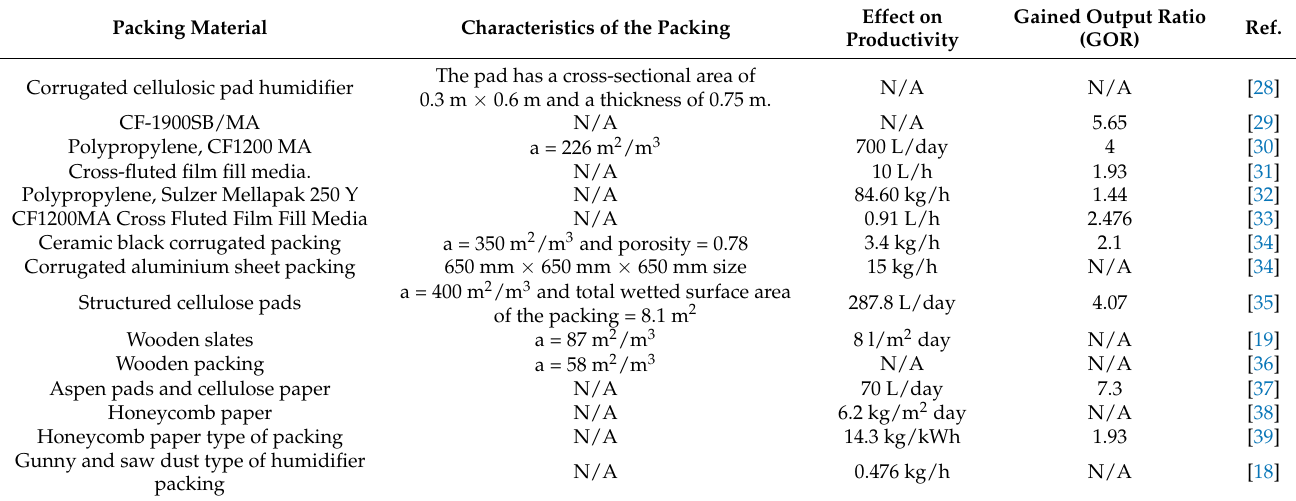
Table 1. Summary of research works on the structure and random packing in the humidifier